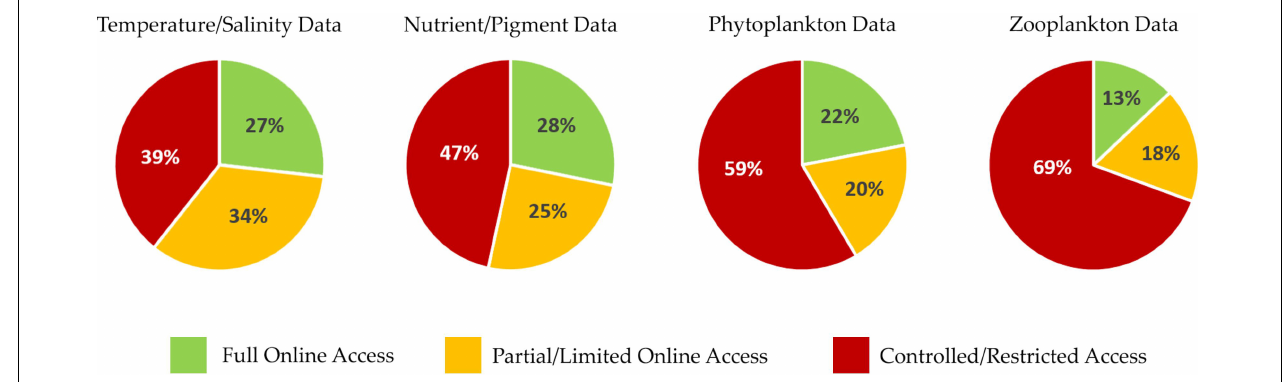
FIGURE 5 | Results of an anonymous survey sent out to all scientists who participated in the International Group for Marine Ecological Time Series (IGMETS) study indicating level of data accessibility by major variable groupings. Green indicates full/free online access to all of the data. Yellow/orange indicates that data are online but have intentional time delays of 2 years or subsetted/incomplete variable sets, requiring users to contact person/institute for the most up-to-date and complete data. Red indicates that none of the data are online and are only available by contacting the data collector or institutional data manager. Compared with physical and biogeochemical data, the percentage of freely available biological data is lower, with a relatively large fraction of zooplankton and phytoplankton data being protected. This likely reflects the amount of time and expertise that is required to collect biological data sets. Training a full species-level microscope plankton taxonomist takes years. Unrestricted and freely available plankton time series tend to be government-run programs with consistent funding that are often tied into legal mandates or water quality